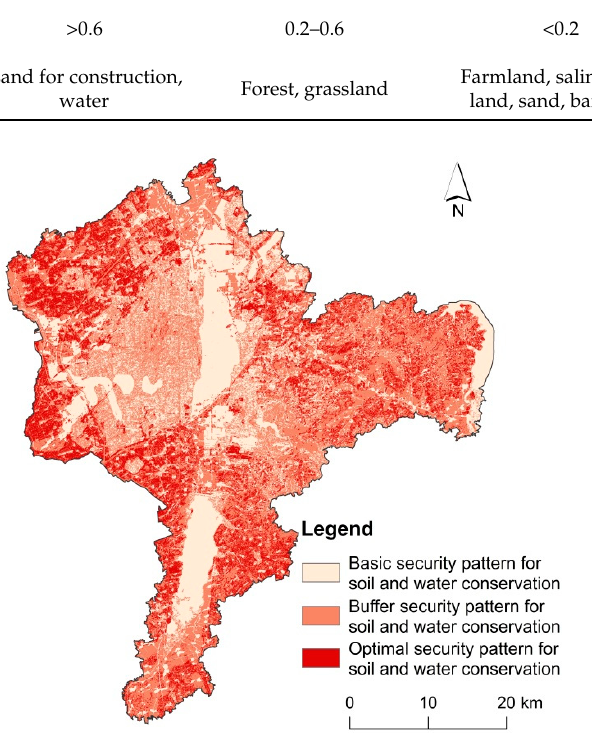
Figure 4. Soil and water conservation security pattern.